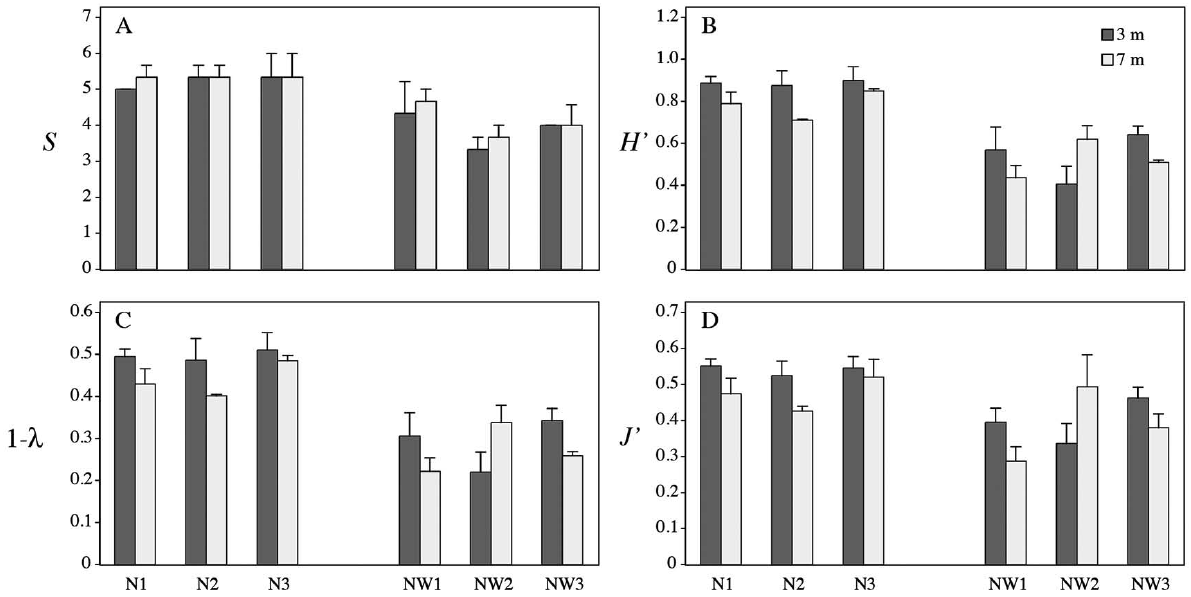
Fig. 3. – Species richness (A), Shannon diversity (B) Simpson diversity (C) and Pielou J’ evenness (D) of epiphytic flora in relation to coastal orientation (North: N1, N2, N3; Northwest: NW1, NW2, NW3) and depth (3 and 7 m). Bars represent means±se